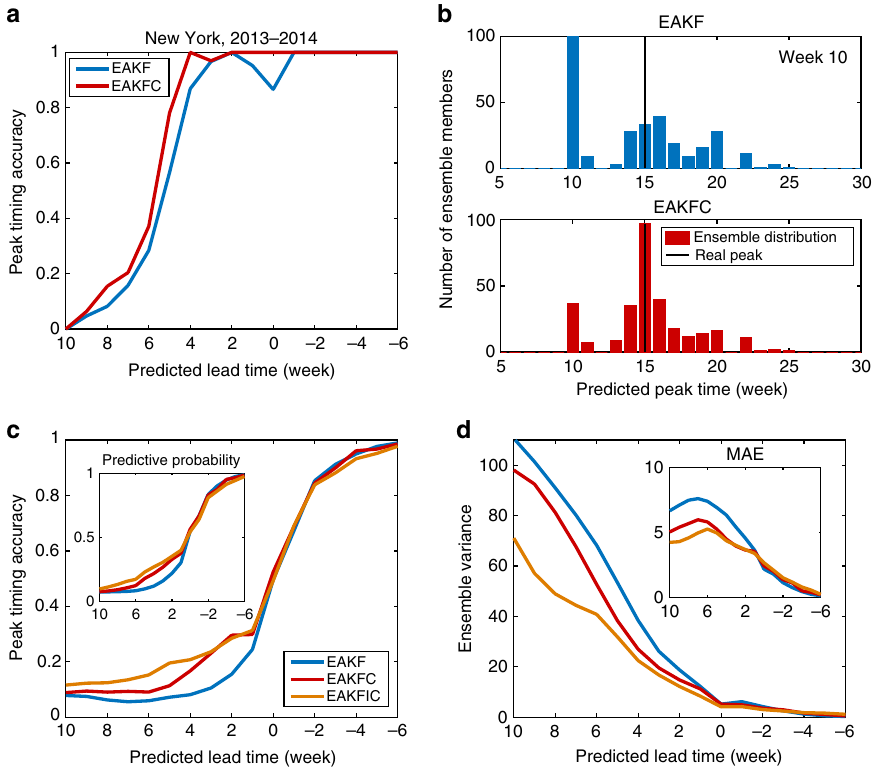
Fig. 2 Comparison of peak timing forecast accuracy for historical in fl uenza outbreaks. a Peak timing forecast accuracy for New York City during the 2013 – 2014 season. For each weekly observation, 100 independent 300-member ensemble predictions were generated. b The distribution of peak timing predictions of EAKF (upper panel) and EAKFC (lower panel) for the 2013 – 2014 season in New York City at 10 weeks after 1 October 2013. The vertical black solid lines indicate the real peak time (week 15). c , d Characteristics of ensemble predictions of peak timing for 95 cities in the United States for the accurate within ± 1 week ( c ), within ensemble variance for those predictions ( d ), predictive probability of real peak time ( ± 1 week) (inset of c ), and MAE of ensemble mean predictions (inset of d ). For each city and week, 100 predictions using the EAKF, EAKFC, and EAKFIC were independently generated. In c , d , a positive value of predicted lead means the peak is predicted to occur in the future, while a negative value implies the peak is predicted to have